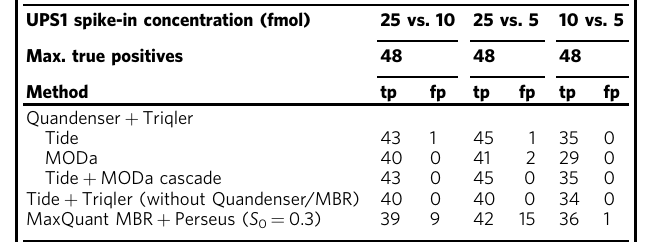
The table lists the numberof true (tp)and falsepositive (fp)signi fi cantly differentiallyabundant proteins at a 5% reported FDR threshold. For Perseus we used S 0 = 0.3, other values ( S 0 = 0.0, 0.7, 1.0) resulted in inferior results (see Supplementary Table 1). Quandenser combined with Triqler achieves a high sensitivity on the UPS – yeast, while still maintaining control of the